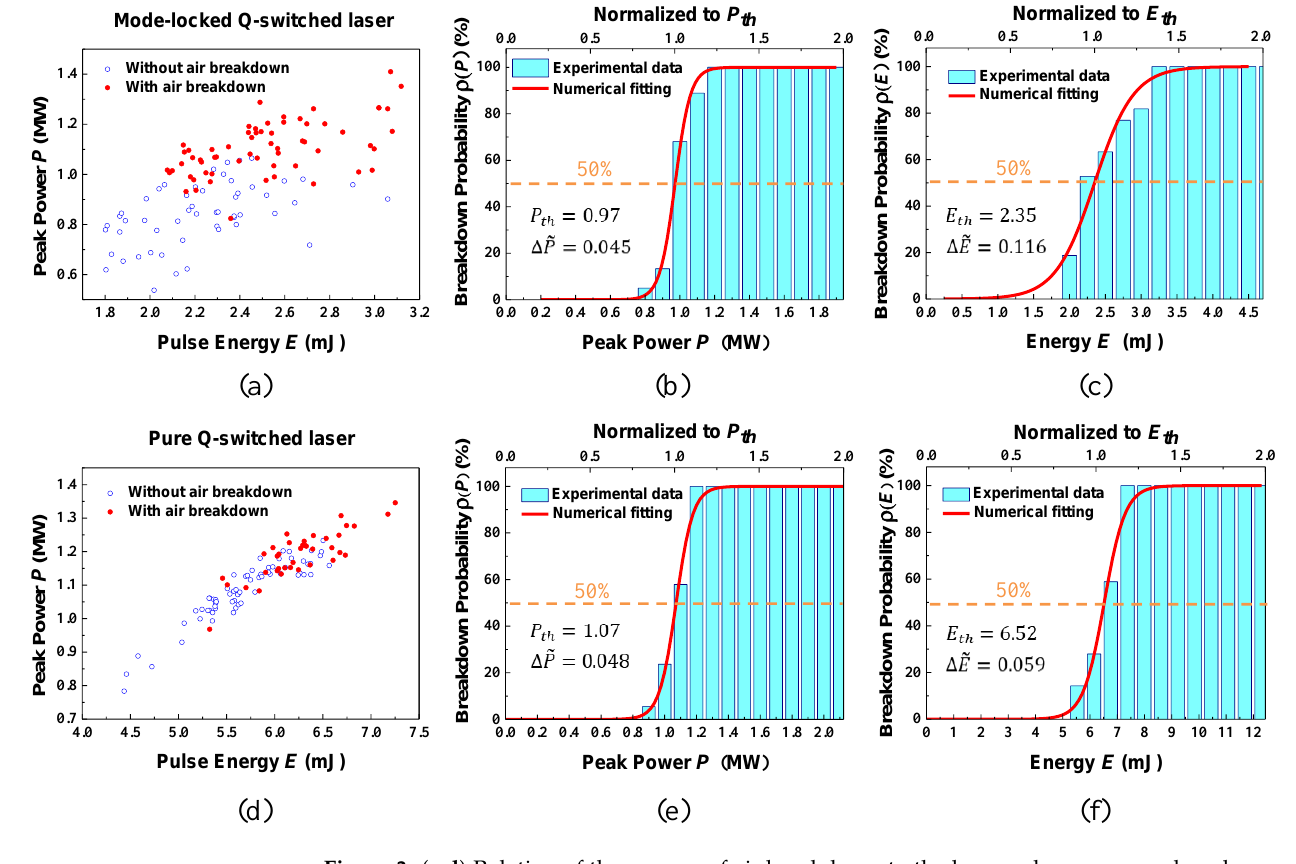
Figure 3. ( a , d ) Relation of the success of air breakdown to the laser pulse energy and peak power with mode-locked Q-switched laser and pure Q-switched laser, respectively. ( b , c , e , f ) Histogram and fitting curve (red line) of the breakdown probability versus the pulse peak power and energy in ( a , d ), respectively.